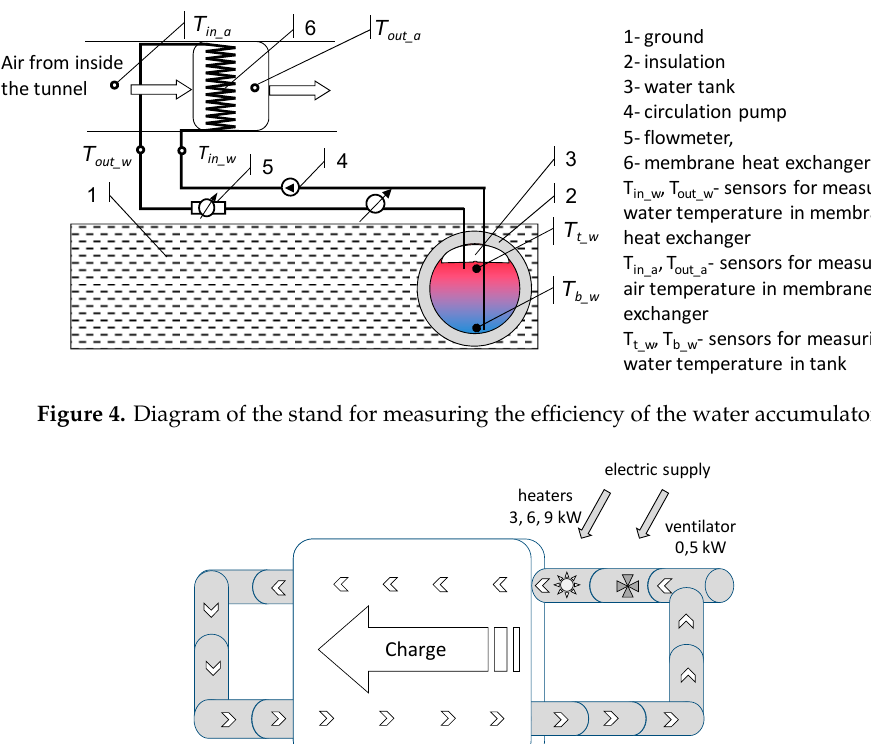
Figure 3. A diagram of an experimental direct contact ground-air heat exchanger located below a semi-cylindrical high plastic tunnel.